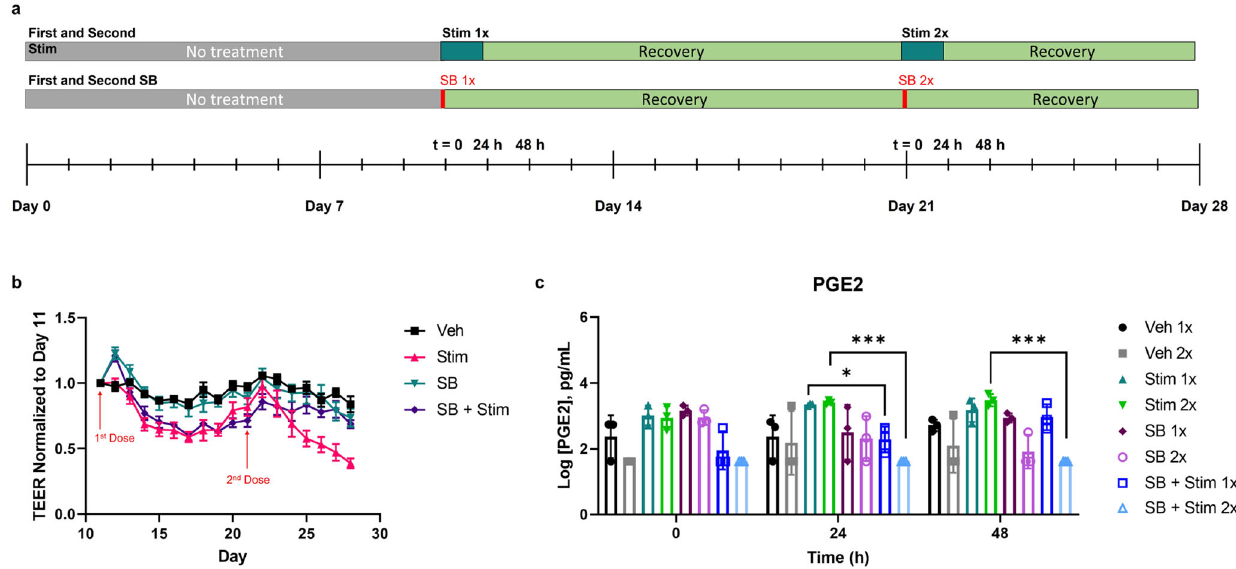
Fig. 5 MOUTH tissue responded to multiple doses of in fl ammatory stimuli and/or inhibitors. a A dosing scheme illustrates consecutive doses of in fl ammatory stimulation and inhibitory treatment with a MAPK inhibitor (SB) versus controls. b Barrier function of Stim devices and Pre-SB + Stim devices trended similarly through the fi rst dose of in fl ammatory stimulants, in which TEER decreased for several days post-stimulation before increasing and plateauing at sub-baseline levels by Day 21. The fi rst dose of in fl ammation stimulant administered on Day 11 of culture (Stim 1x) decreased TEER values by 31% within 3 days and recovered to 82% of baseline TEER within 10 days. TEER values of devices pre-treated with SB prior to the fi rst dose of stimulant (Pre-SB + Stim), decreased by 23% within 3 days and recovered to 71% of baseline TEER within 10 days. The trend of the two conditions diverged after the second dose, which was administered 10 days after the fi rst dose. The second dose (Stim 2x), did not signi fi cantly reduce TEER in the fi rst 48 h, but ultimately TEER was reduced by 60% by 7 days post-second dose relative to Day 11 values. By the end of culture on Day 28, compared to the average TEER measured on Day 11 before Stim 1x, TEER of Stim devices had decreased by 61%, and TEER of Pre-SB + Stim devices had decreased by 31%. TEER of vehicle control devices had decreased by 16%. c Secreted PGE2 levels increased 24 hours after devices were stimulated the fi rst time (Stim 1x). These levels recovered to pre-stimulation levels by the second round of dosing, on day 21, when the same devices were dosed again with IL-1 β and TNF- α (Stim 2x). With the second dose, secreted PGE2 levels increased within 24 h, following the same trend as the fi rst dose. SB 2x devices had a decrease in PGE2 release, also similar to the fi rst dose of SB on day 11. Pre-incubation with SB inhibited in fl ammatory response for 24 h after the fi rst and second in fl ammatory doses, as indicated by the preservation of PGE2 levels compared to Stim conditions. Data represent at least three replicates from one experiment. In all cases, error bars represent standard deviation. Signi fi cance was determined by unpaired Welch ’ s t -test. Signi fi cance: * p <